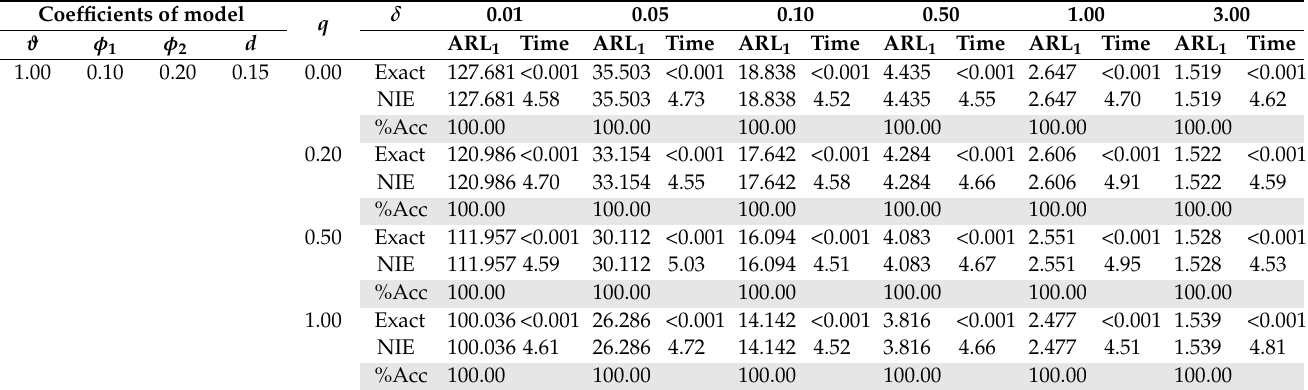
Table 7. The ARL 1 results using the exact formula and the numerical IE technique for ARFI(2, d ) processes running on the modified EWMA control chart with λ =